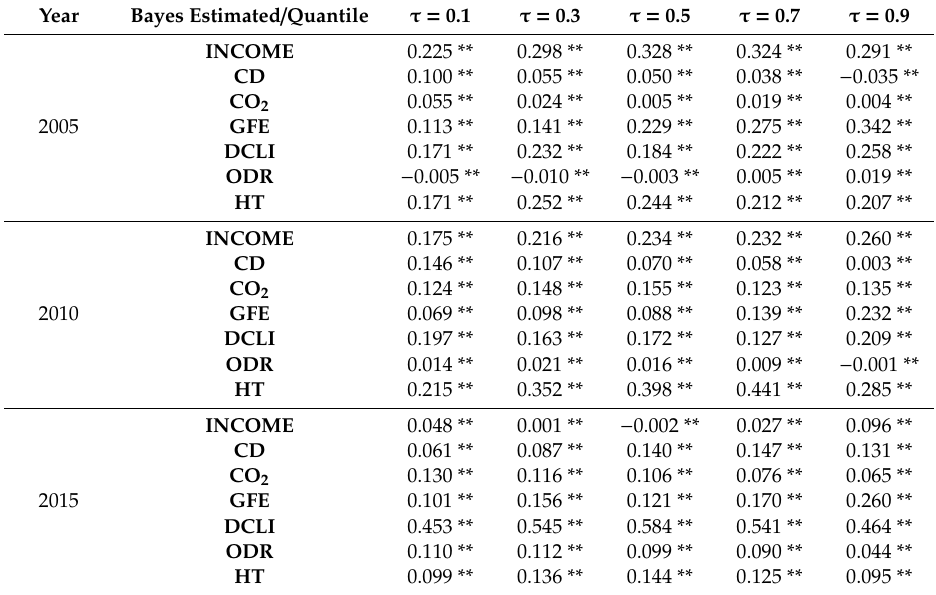
Table 8. Quantile regression estimation of di ff erent quantiles in 2005, 2010, and 2015.